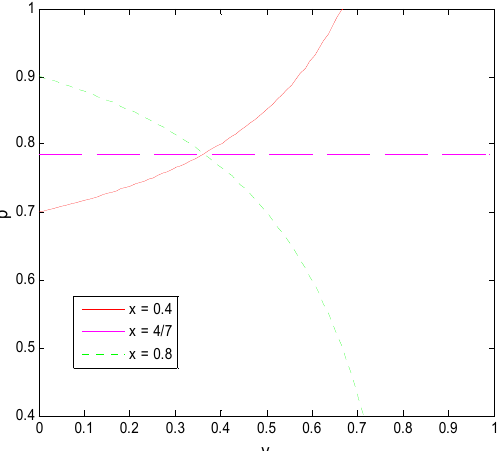
Figure 15. The e ff ect of the income distribution coe ffi cient on faculty inventors’ will to “comply with rules”. Figure 15. The effect of the income distribution coefficient on faculty inventors’ will to “comply with rules”.